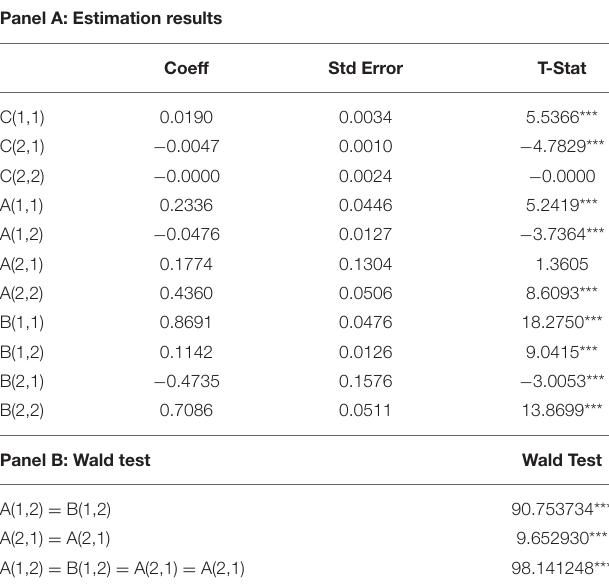
Panel A: Estimation results